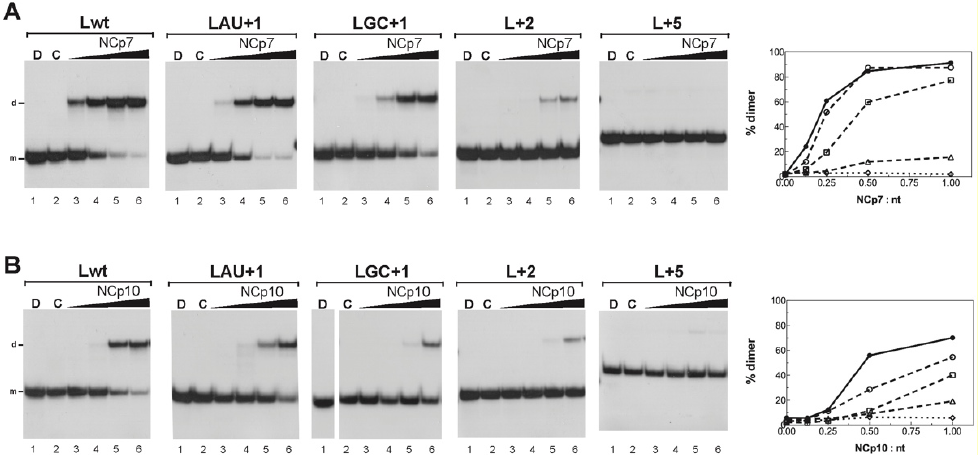
Figure 8. Influence of stem C extensions on L3 RNA dimerization induced by NCp7 and NCp10. ( A ) NCp7-mediated L3 RNA dimerization. ( B ) NCp10-mediated L3 RNA dimerization. The 5 ′ -end- labeled L RNAs in the absence (lanes C) or the presence of NCp7 or NCp10 (lanes 3–6) were incubated at 37 °C as described in Materials and Methods. After phenol–chloroform extraction, the samples were analyzed by electrophoresis on 12% polyacrylamide gels at 25 °C in the TBE buffer. Heat- denatured L RNAs (lanes D) were used to identify the bands corresponding to monomeric L RNAs. Lanes 3–6, protein to nucleotide molar ratios were 1:8, 1:4, 1:2, and 1:1. The monomeric and dimeric forms of L RNAs are indicated by m and d, respectively. The graphs were derived from the gels shown in this figure. Filled circles, Lwt RNA; open circles, LAU+1 RNA; open squares, LGC+1 RNA; open triangles, L+2 RNA; open diamonds, L+5 RNA.